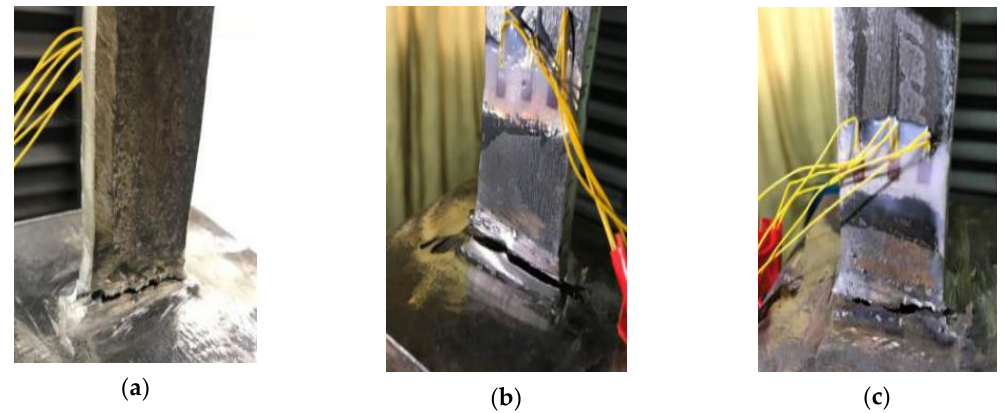
Figure 6. Weld damage of plate joints under monotonic loading: ( a ) S-1; ( b ) S-2; ( c ) S-3.